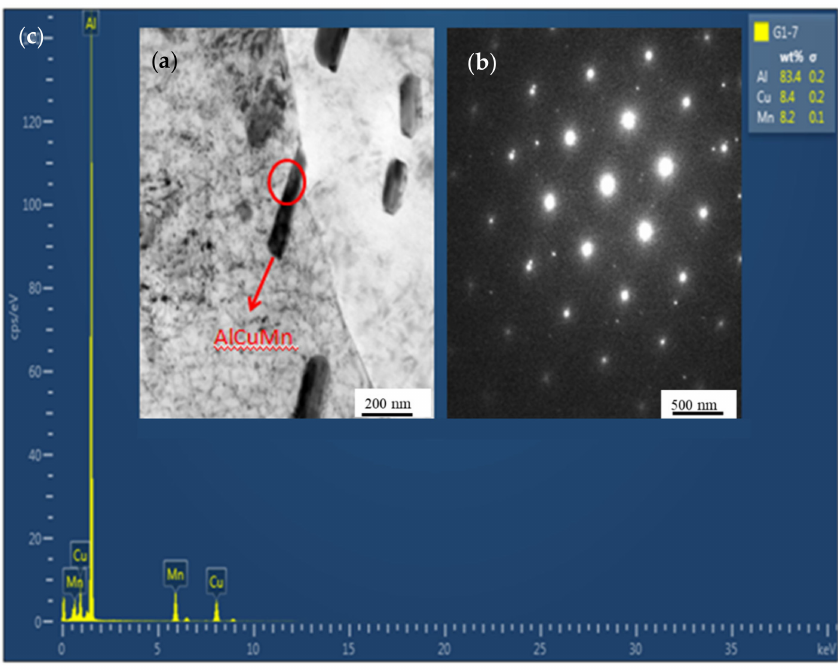
Figure 5. The morphology of AlCuMn particle precipitated along the grain boundary ( a ), and the corresponding diffraction pattern ( b ) and EDS result ( c ).